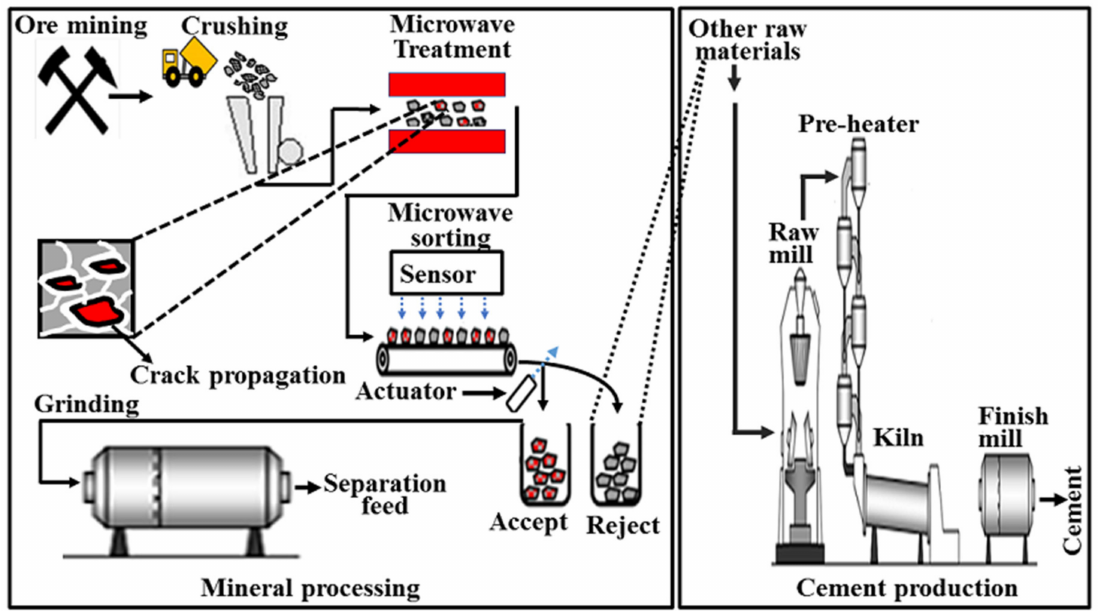
Figure 1. Microwave-assisted sorting and grinding; mineral processing (modified after [24]) and microwave-assisted grinding; cement production (modified after